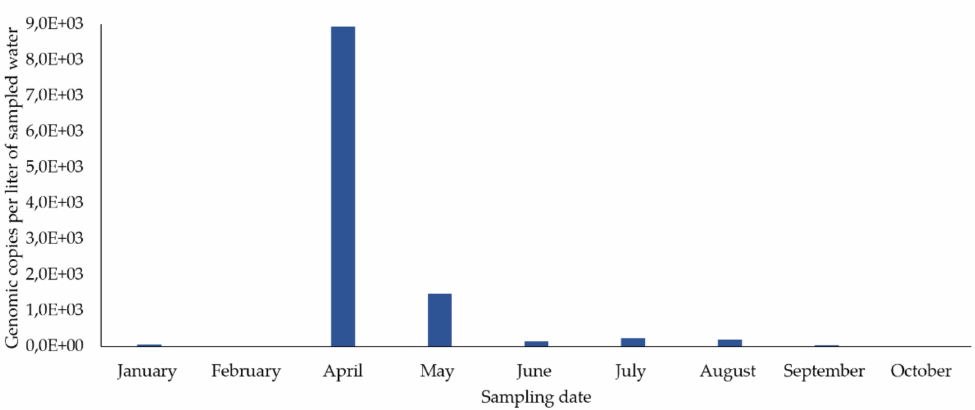
Figure 3. Variation in the concentration of HEV RNA detected in concentrated drinking water from the sampling point in the distribution network during 2019 ( n = 9). RT-qPCR results (average values of two independent reactions), in gc / L, indicate estimated genomic copies per liter of sampled water (based on data from Table